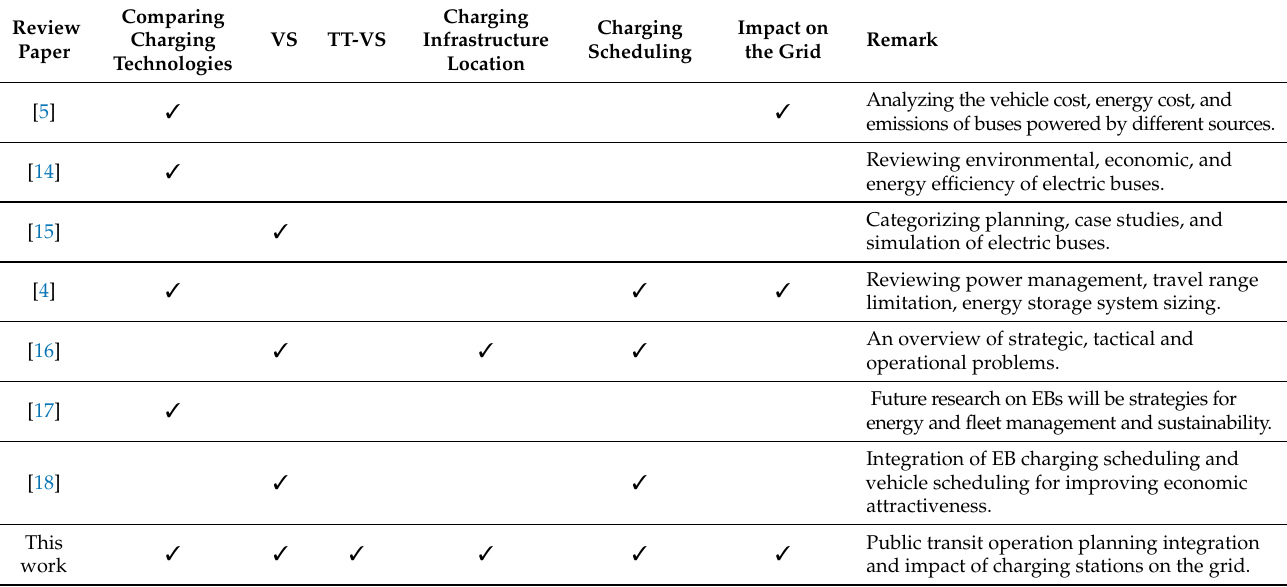
Figure 3. Problems that significantly impact the operation planning of EBs. Table 1. Comparing different review papers with the current